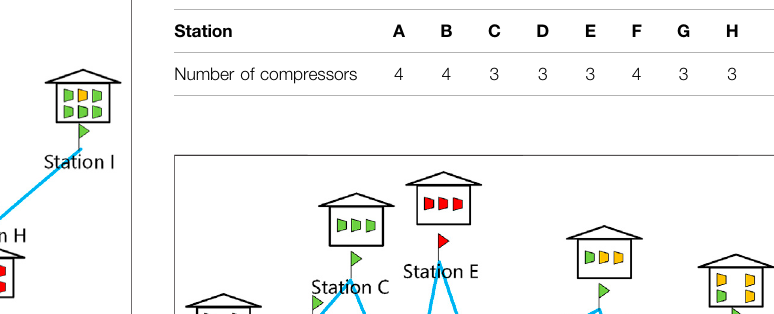
TABLE 1 | Compressor information along the pipeline.